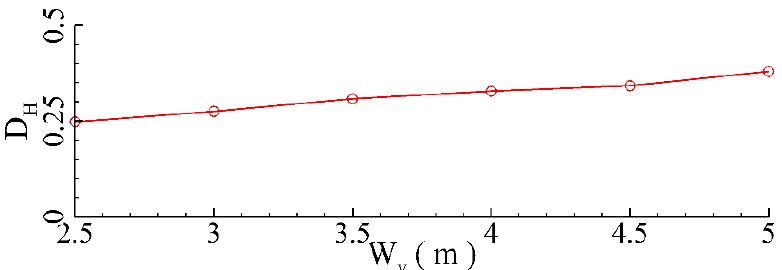
Figure 31. Dissipation rate of the local maximum wave height under different vegetation lengths.